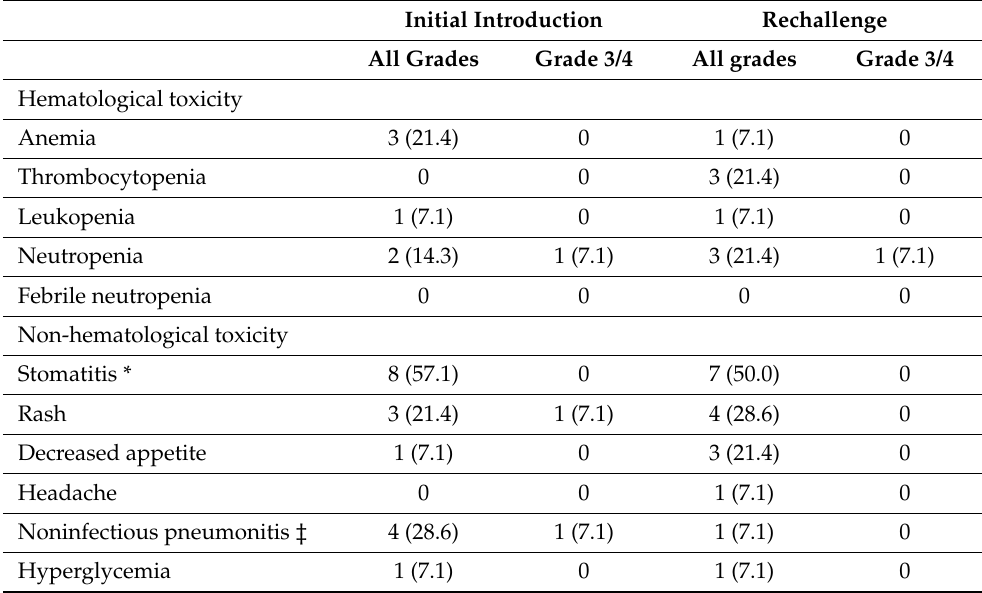
Table 3. Toxicity of everolimus during rechallenge and at the time of the initial introduction ( n =